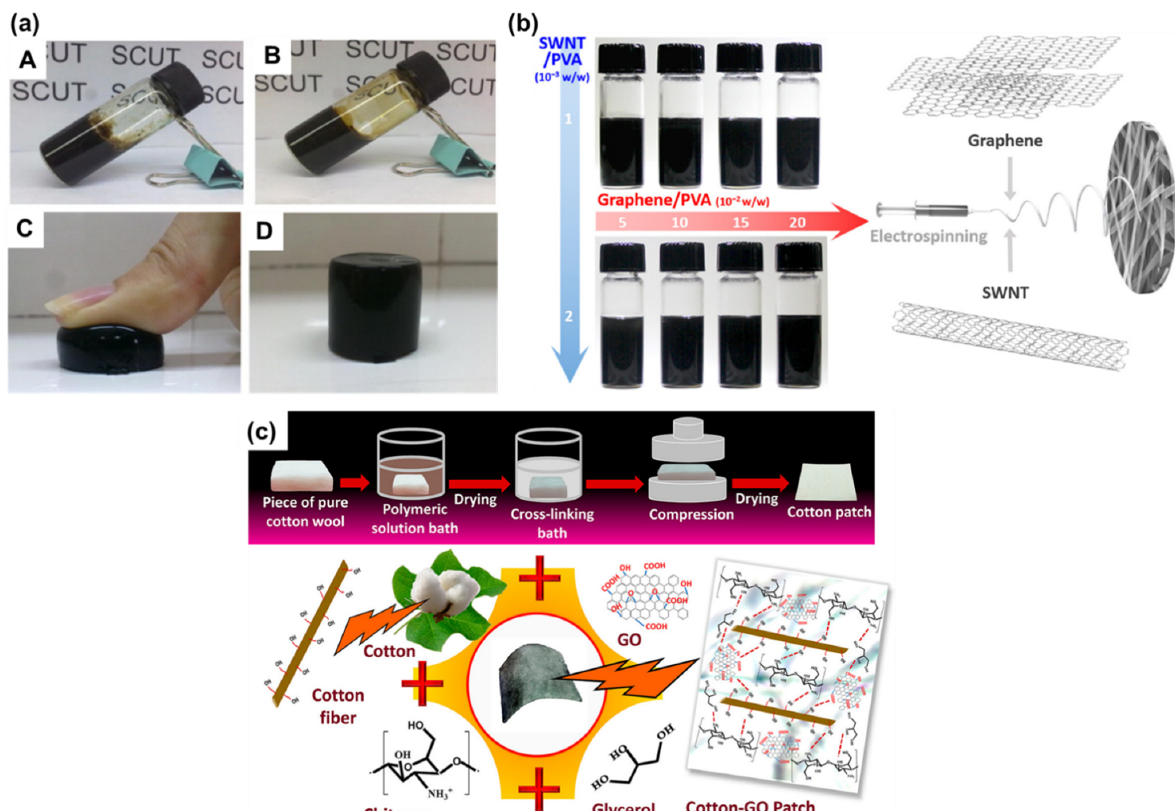
Figure 9. ( a ) GO-NIPAM suspensions, ( A – D ) images reproduced with permission from ref. [146], ( b ) Scheme depicts the dispersion of SWNT/graphene/PVA which were electrospun to yield nanofibers, reproduced with permission from ref. [151], and ( c ) schematic representation showing the fabrication of biopolymeric hydrogel coated cotton patches, reproduced with permission from ref. [159].